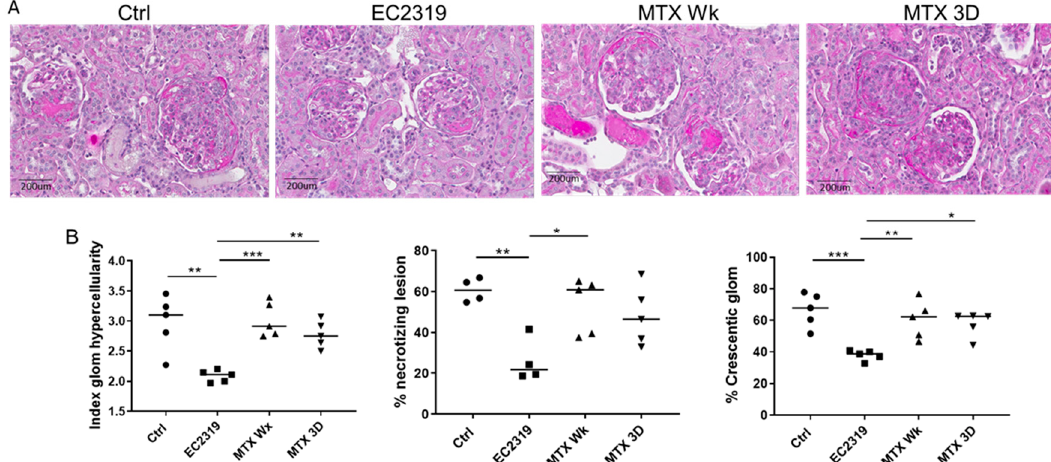
Figure 8. MTX does not protect from kidney injury in anti-GBM GN: ( A ) PAS staining of kidney sections of WKY rats with anti-GBM GN and treated with vehicle, EC2319, MTX once a week (MTX Wk), and MTX at equimolar basis to EC2319 (MTX 3D). ( B ) Quantitation of kidney injury in control rats, rats treated with EC2319, MTX Wk and MTX 3D. In control rats, severe glomerular hypercellularity, necrotizing lesion, and crescent formation were observed. In rats treated with EC2319, the glomerular injury is significantly reduced; however, MTX (MTX Wk and MTX 3D) is unable to attenuate kidney damage. Results were sampled from five rats per group and expressed as mean ± SEM. * p < 0.05, ** p < 0.01, *** p < 0.001. • Control, EC2319, MTX Wk, MTX 3D.